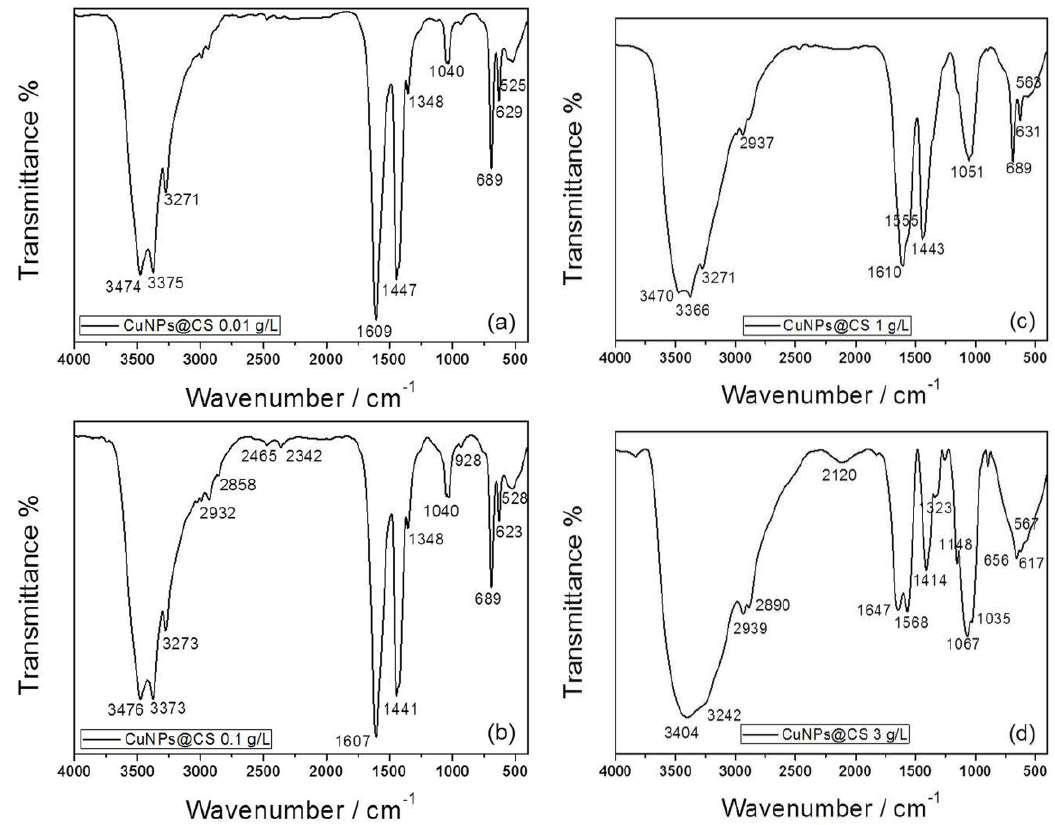
Figure 5. Fourier transform infrared (FTIR) spectra of freshly-prepared CuNPs stabilized by CS (CuNPs@CS nanocomposites, “@” stands for “stabilized by”), synthetized at CS concentrations of: ( a ) 0.01 g/L; ( b ) 0.1 g/L; ( c ) 1 g/L; ( d ) 3 g/L.